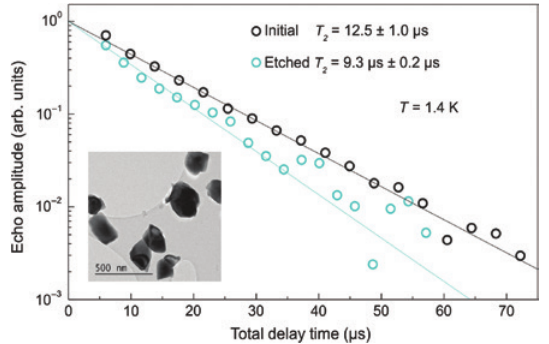
O nanoparticles before and 2 3